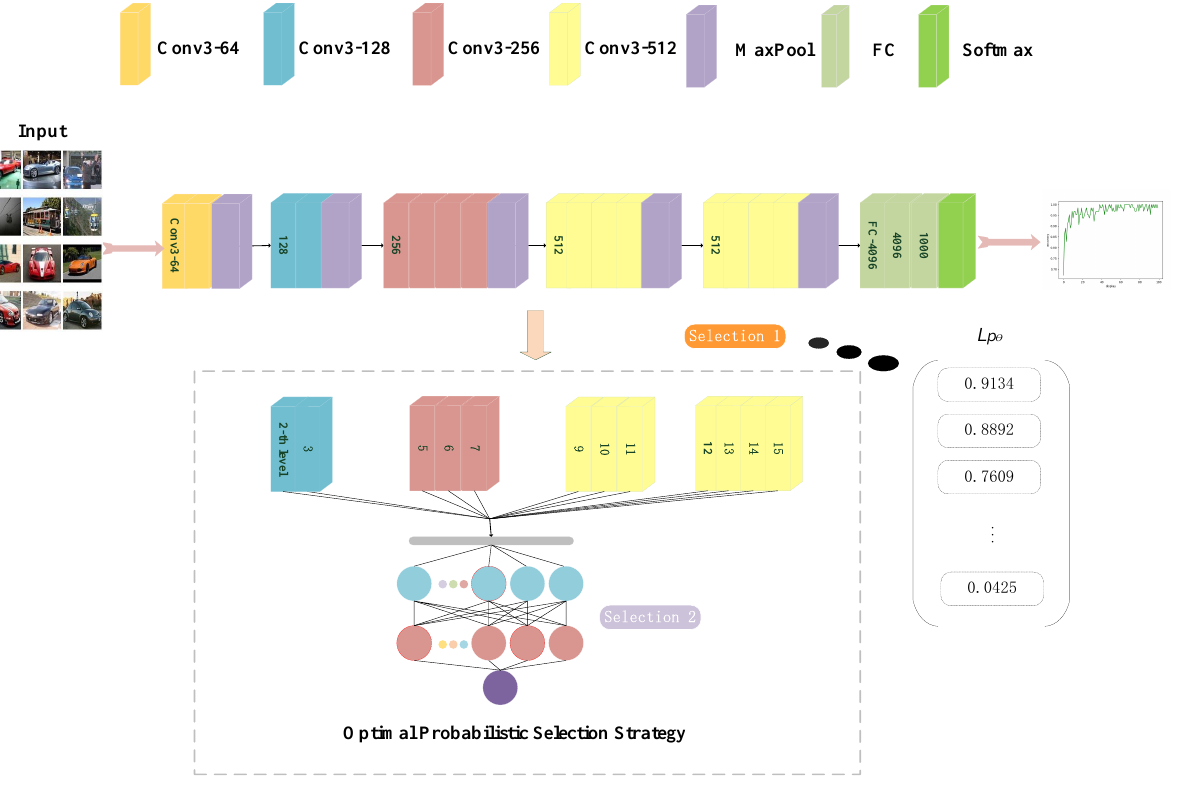
Figure 4. Schematic diagram of